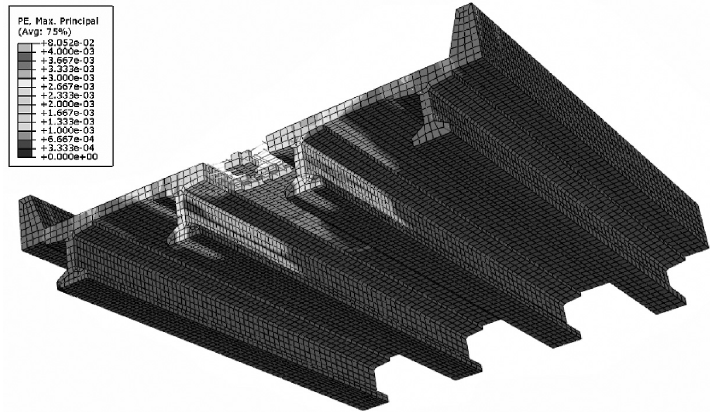
Fig. 20. Maximum principal plastic strain, blast above, between girders. Bottom